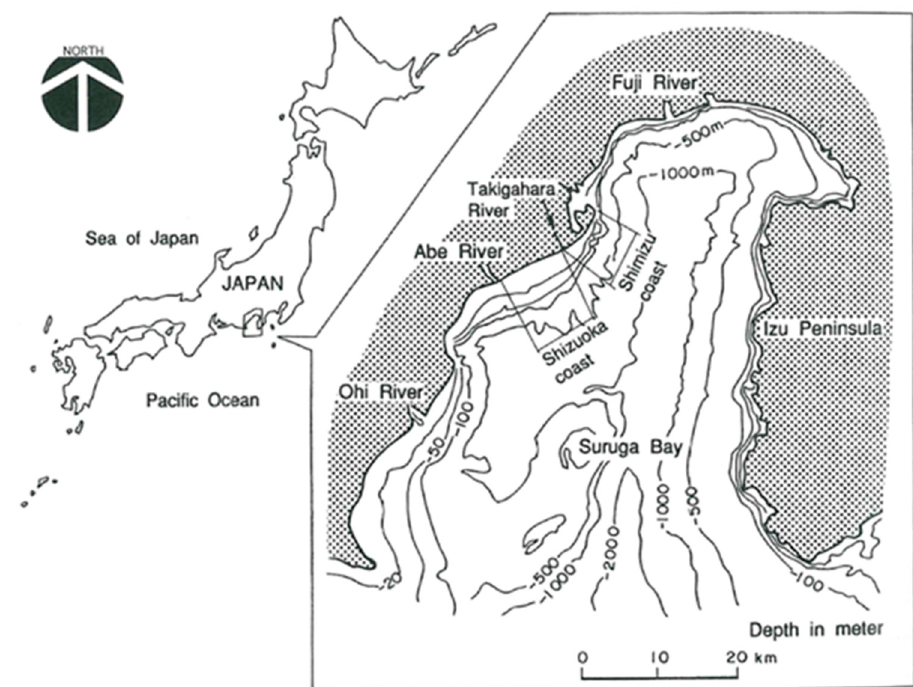
Figure 30. Bathymetric chart of Suruga Bay in Japan [20].